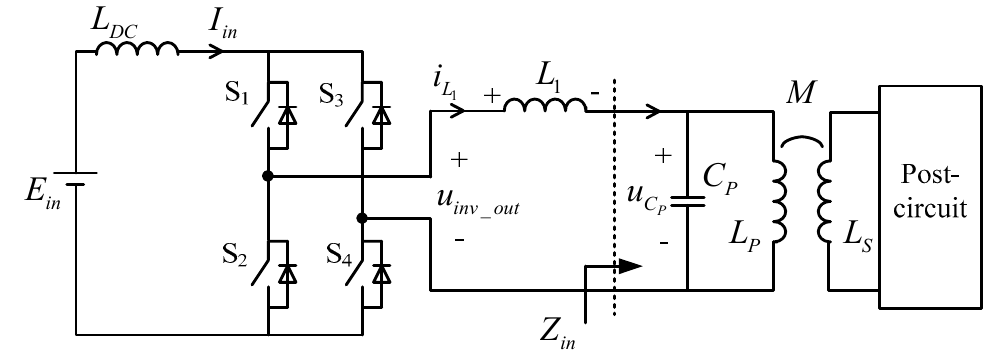
Figure 5. Current-Fed WPT system using the proposed inductance-damping method.